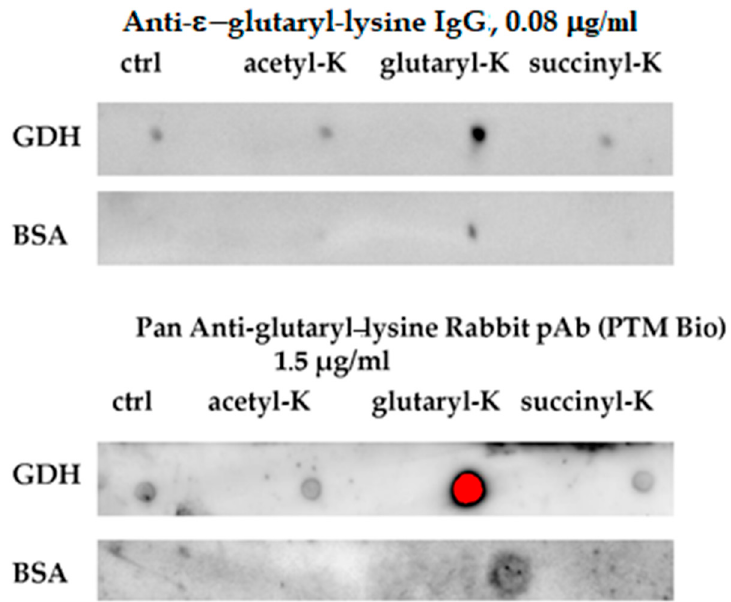
Figure 2. Comparison of specificity and selectivity of the home-made and commercial anti-( ε -glutaryl- lysine) antibodies, using purified proteins with artificially modified lysine residues (see details in Materials and Methods). An amount of 1.5 µ g/mL concentration of commercial antibodies represents the one recommended for immunoblotting by the manufacturer.